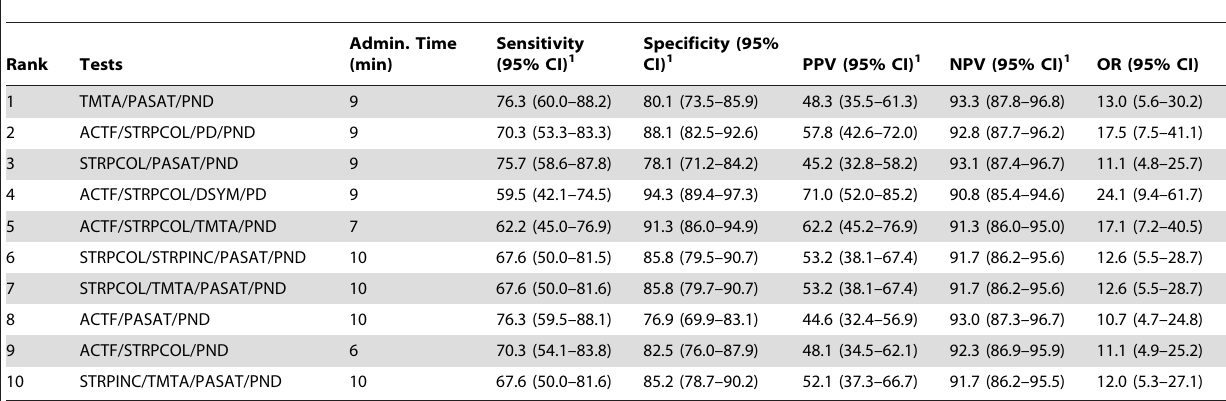
Table 5. Top 10 testing combinations, ranked according to sum of sensitivity and specificity compared to a 120 minute global neuropsychological battery, that take 10 minutes or less to